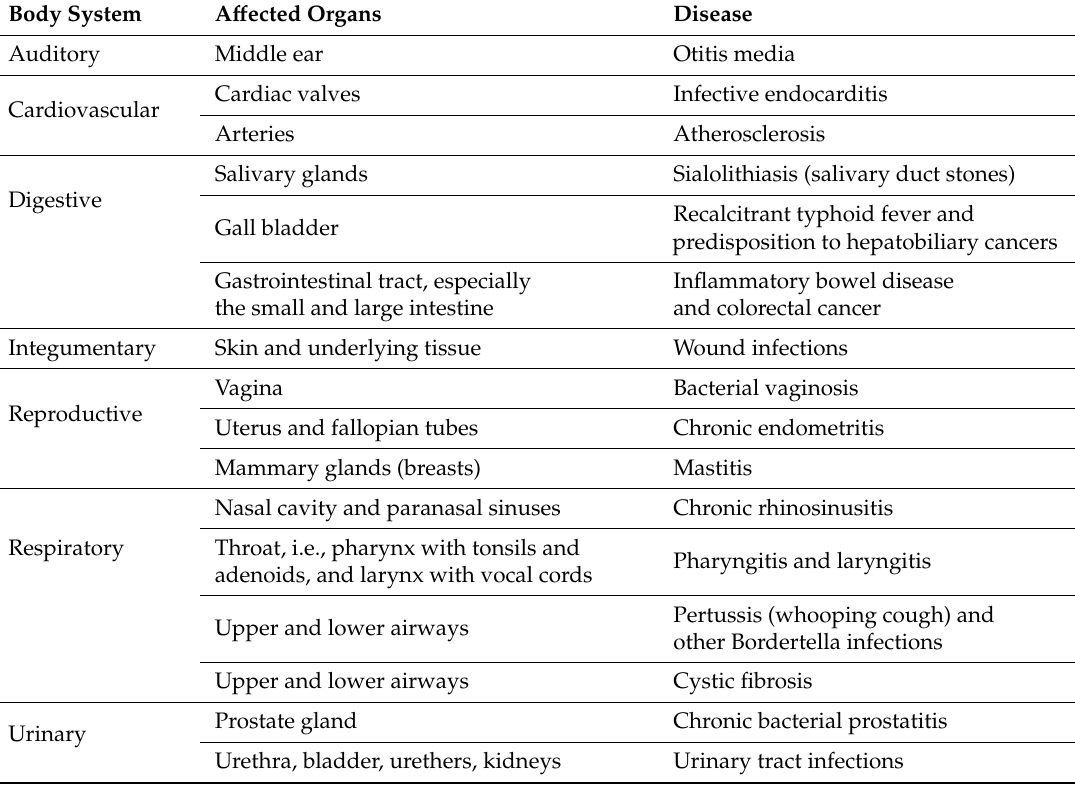
Table 1. Biofilm-associated diseases of di ff erent body systems and their a ff ected